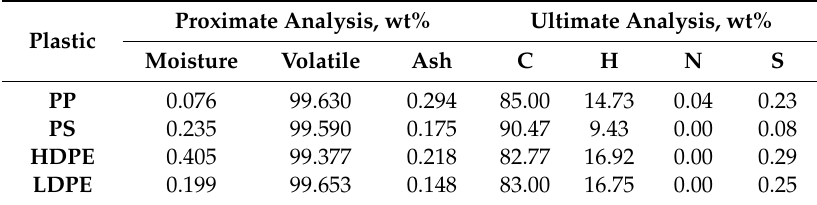
Table 1. Ultimate and proximate analysis of di ff erent waste plastics.